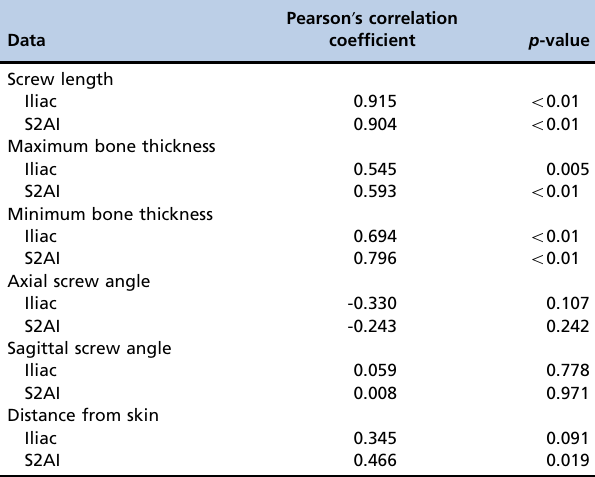
Table 3 - Comparison of the Pearson ’ s correlation